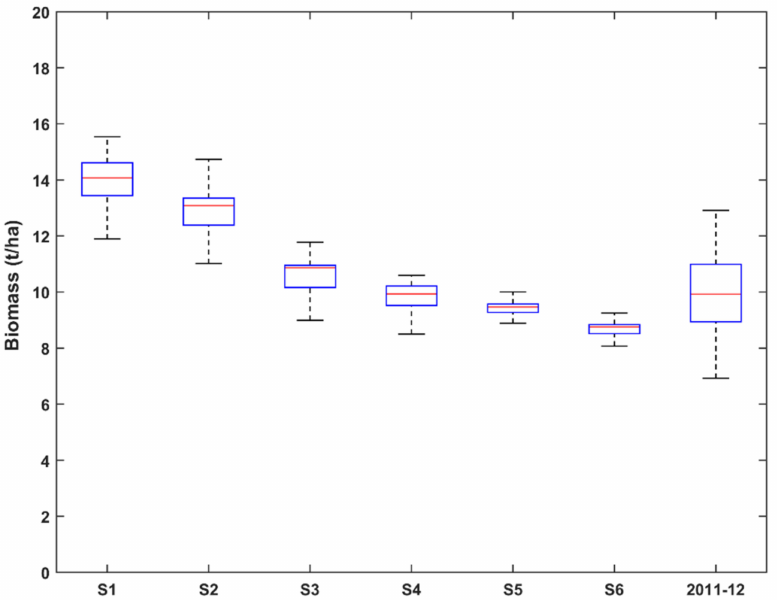
Figure 15. Variation of the biomass (t/ha), between simulated scenarios and the real case (2011–2012 agricultural season) based on the AquaCrop model. The statistical Student’s t -test shows that S1 and S2 are identical ( p > 0.05), and the other scenarios are significantly different ( p ≤